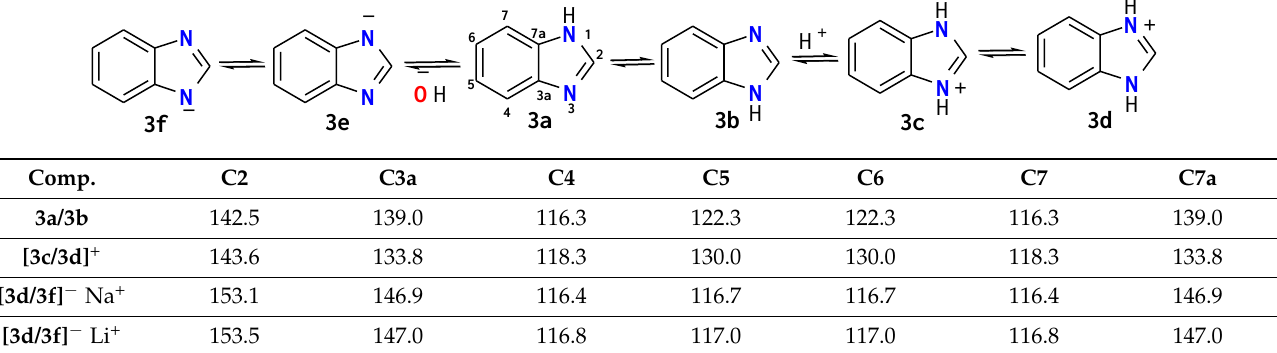
Table 3. Protonation and deprotonation of BMZ 13 C in DMSOd 6 .